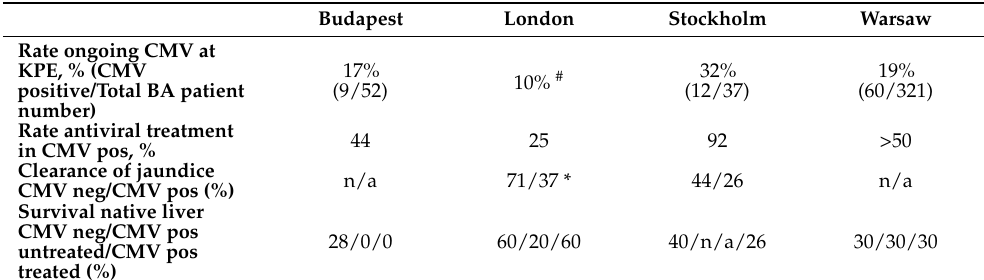
Table 4. Rate and treatment of ongoing cytomegalovirus (CMV) infection in biliary atresia patients at the time of Kasai portoenterostomy.